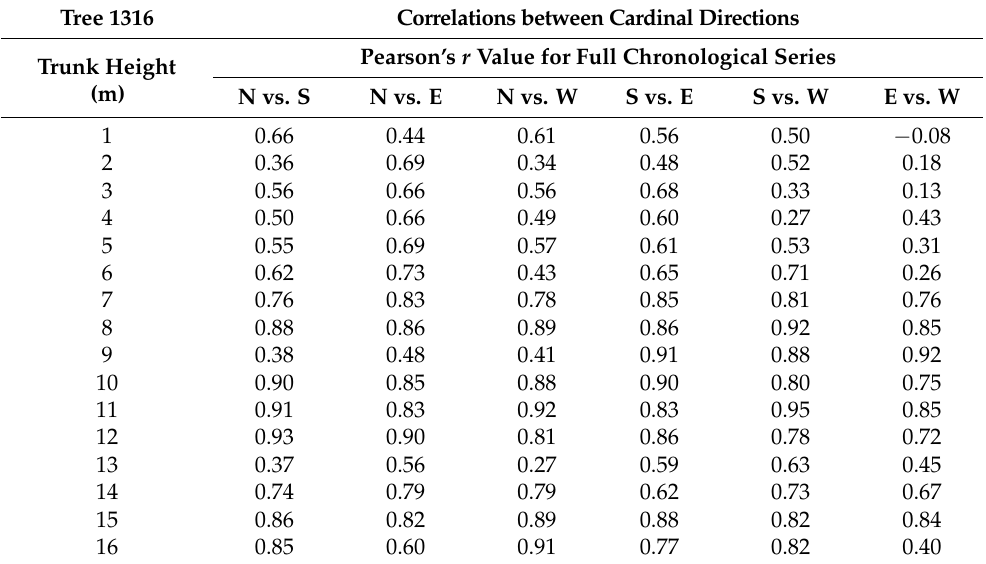
Table 4. Similarity of overall radial gišogenesis between cardinal directions at each trunk height in tree 1316. Tree 1316 Correlations between Cardinal Directions Trunk Height